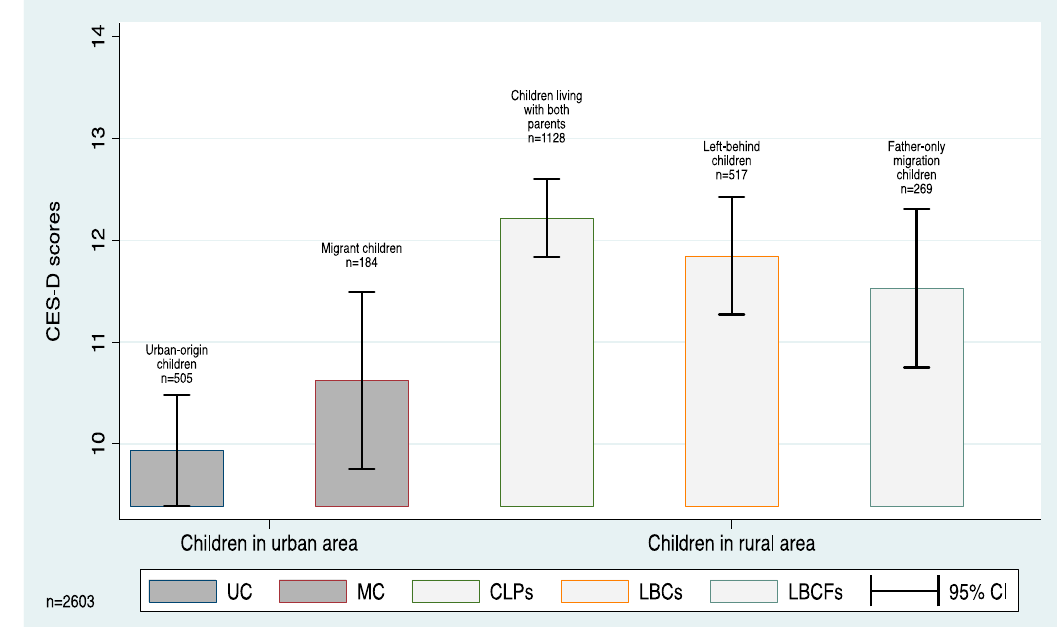
Figure 1. The Differences of CES ‐ D Scores among Children of Different Household Migration Patterns and Residency Statuses with 95% Confidence Interval (CI). Source: CFPS (2012). Notes: Migrant children (MC) are specified as children under the age of 16 who have rural Hukous and migrate to urban areas for at least 6 months per year; Left ‐ behind children (LBC) are specified as children under the age of 16 who have been left ‐ behind in rural areas while both parents migrate to other areas for at least 5 months per year. We do not evaluate the sample of “Mother ‐ only migration children”, because this sample size is too small. The p ‐ value of the difference between Migrant children and Urban ‐ origin children is 0.1951 by t ‐ test. The p ‐ value of the difference between Migrant children and all rural children is 0.0039 by t ‐ test. The p ‐ value of the difference between Migrant children and children living with both parents is 0.0019 by t ‐ test. The p ‐ value of the difference between Left ‐ behind children and children living with both parents is 0.2866 by t ‐ test. The p ‐ value of the difference between Father ‐ only migration children and children living with both parents is 0.1178 by t ‐ test.